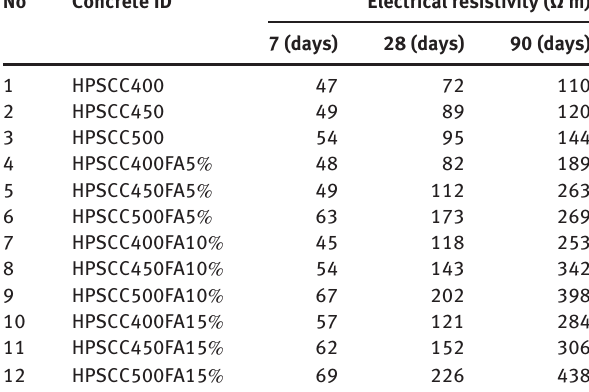
Table 12 Results of electrical resistivity for different